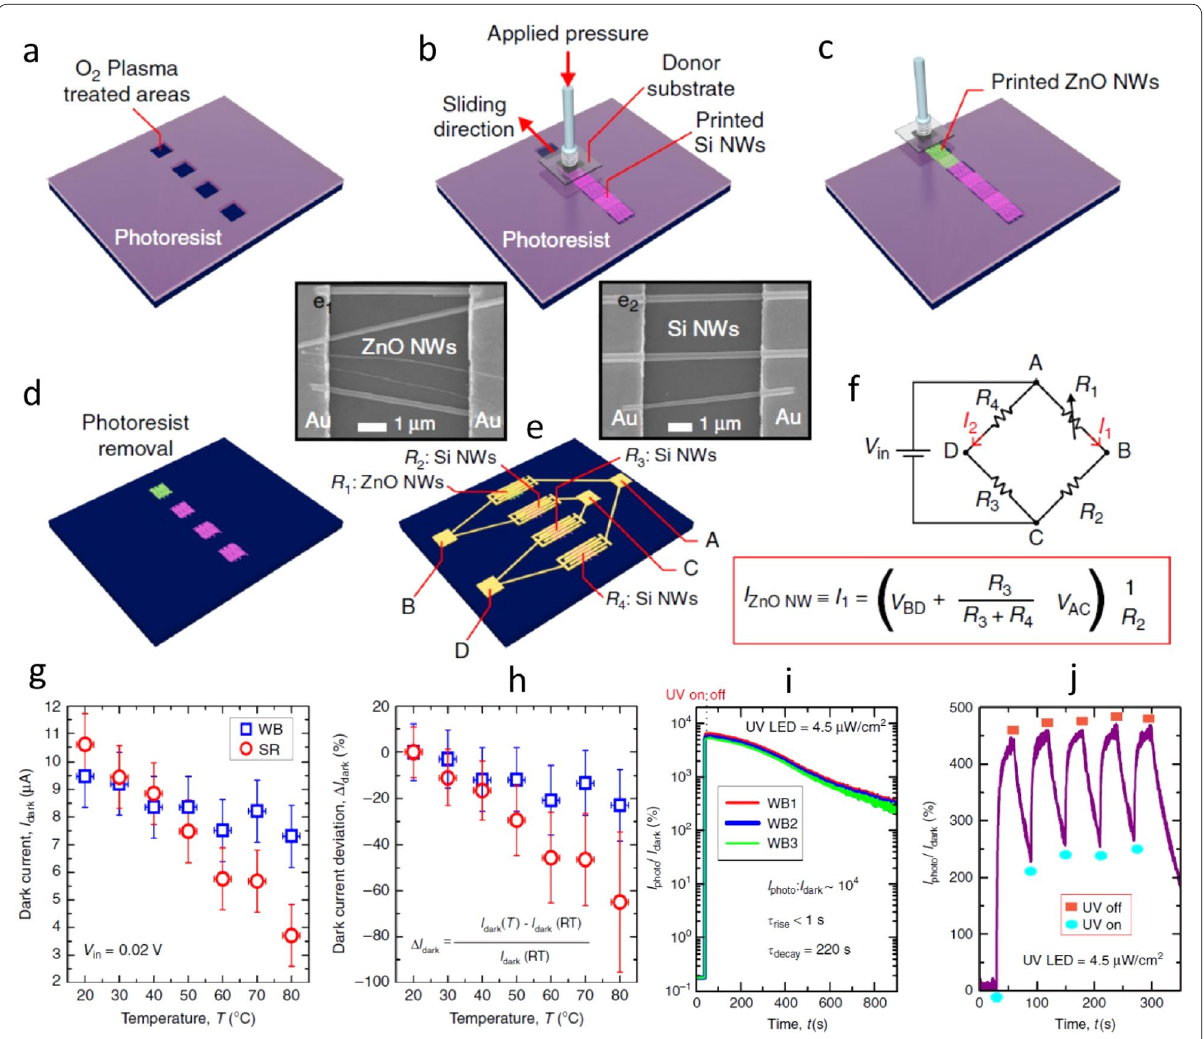
Fig. 11 a – e 3D Schema of UV Photodetector fabrication using contact printed ZnO and Si NWs. Fabrication steps of UV PDs based on ZnO and Si NWs, comprising: ( a ) definition of 20 mm 2 areas on a S1818 photoresist layer by photolithography, followed by an O2 plasma treatment (100 Watt and 0.3 mbar for 1 min). Contact Printing of ( b ) Si and ( c ) ZnO NWs. d removal of the photoresist in warm acetone (50 °C for 2 min). e definition of Ti(4 nm)/Au(200 nm) interdigitated electrodes by photolithography and lift-off, where (e1) and (e2) show SEM images of printed ZnO and Si NWs, respectively, bridging a pair of Ti/Au electrodes with a 5 μm gap. f WB equivalent circuit and the expression determining the electric current flowing through ZnO NWs. g I dark and ( h ) ΔI dark vs. Temp. for WB and single resistance (SR) UV PDs. i Single cycle and ( j ) multi-cycles measured over time and using a UV LED power density of 4.5 μW/cm 2 and a V in of 0.05 V, keeping a distance between UV LED and the PD surface of 5 cm. Reprinted with permission from Ref.